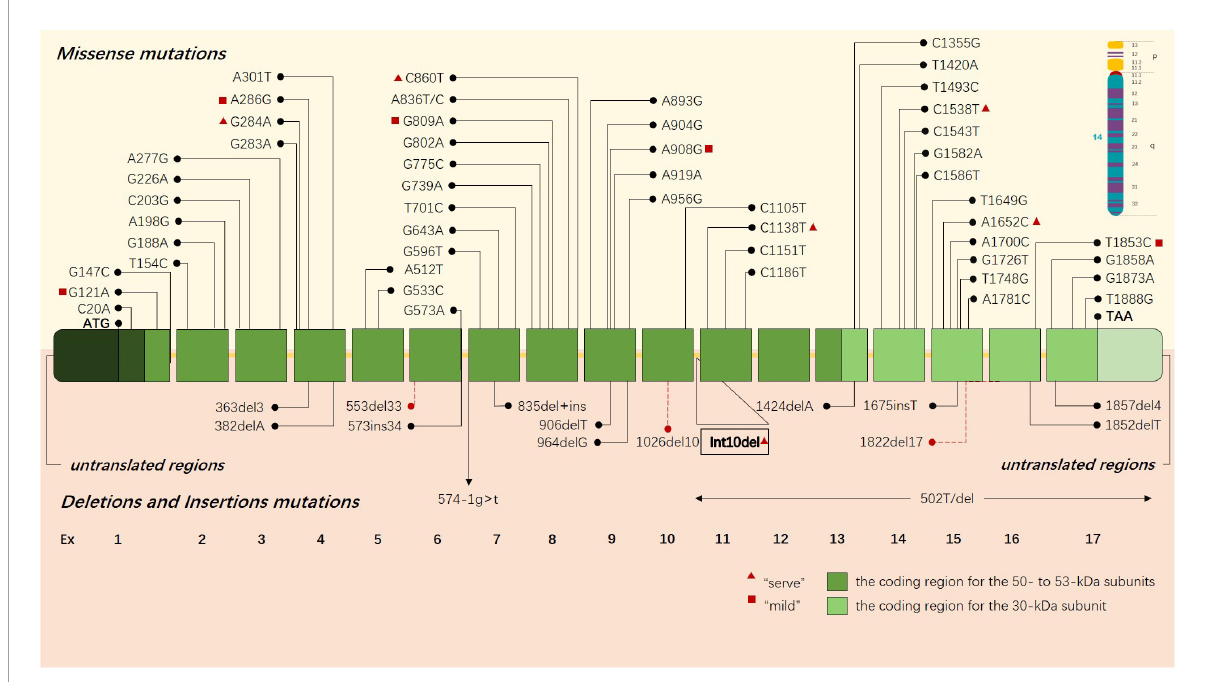
FIGURE1 GLD-causing common sites and types of gene mutations are presented in the schematic drawing of GALC gene. Missense mutations are above the gene, and deletions and insertions are shown below the gene. Each box represents an exon, the dark green boxes contain the coding region for the 50- to 53-kDa subunits, and the light green boxes contain the coding region for the 30-kDa subunit. The red triangle indicates that this gene may cause a severe clinical phenotype, and the red square indicates that the gene may lead to a mild clinical